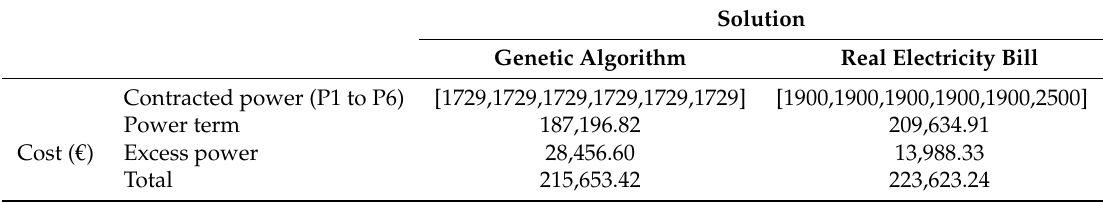
Table 3. Comparison between current contracted power and results obtained by the genetic